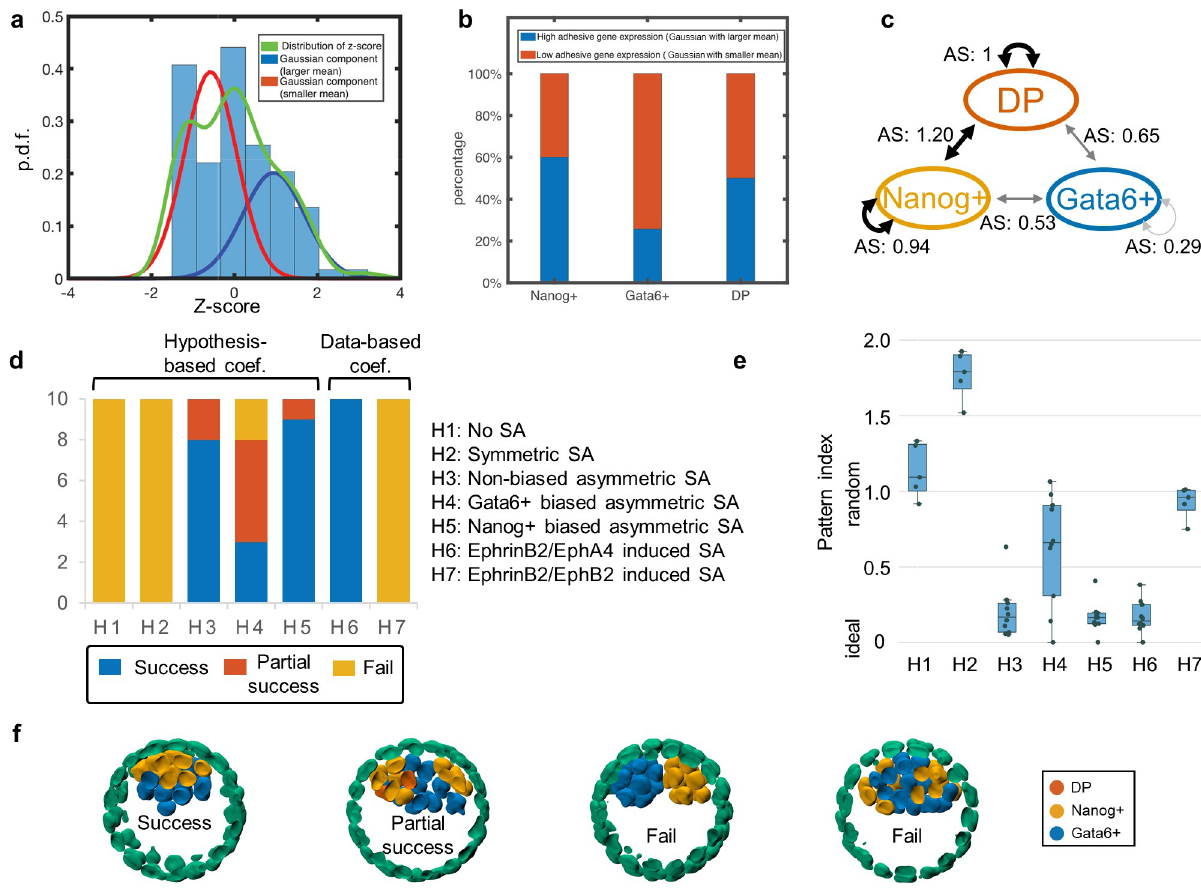
Fig 2. Data-informed selective adhesion model leads to successful cell arrangement at 128 cell stage. (a) Histogram of z-score of summation of log ([EphA4] + 1) and log([EphrinB2] + 1) at E4.5 stage. The green curve shows the distribution of z-score. The red and blue curves show two components of Gaussian Mixture to fit the distribution. (b) Percentage of high/low adhesive gene expression levels in Nanog+/Gata6+/DP cells at E4.5 stage. (c) An EphA4/EphrinB2 driven selective adhesion mechanism between Nanog+/Gata6+/DP cells, where higher adhesion score (AS) indicates stronger adhesion, and a positive AS means strengthened adhesion. (d) Success rate for Nanog+/Gata6+ cells arrangement in simulations with different selective adhesion hypotheses: (H1) no selective adhesion; (H2) symmetric selective adhesion where adhesion between Nanog+/Nanog+, Gata6 +/Gata6+ and DP/DP cells are the same; (H3) asymmetric selective adhesion where DP cells have same adhesion with Nanog+ and with Gata6+; (H4) asymmetric selective adhesion where DP cells have stronger adhesion with Nanog+ cells than with Gata6+ cells; (H5) asymmetric selective adhesion where DP cells have stronger adhesion with both Nanog+ and Gata6+ cells; (H6) the EphA4/EphrinB2 driven selective adhesion; (H7) the EphB2/ EphrinB2 driven selective adhesion. (e) Pattern loss score of the simulations. Each data point corresponds to one simulation. A loss score of 0 indicates a perfect pattern and random cell type assignments have an expected loss score of 1. (f) Representative terminal Nanog+/Gata6+ cell arrangements for successful, partially successful, and failed